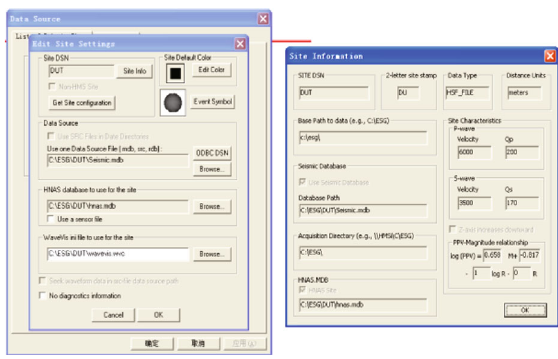
Figure 24: System parameter setting.